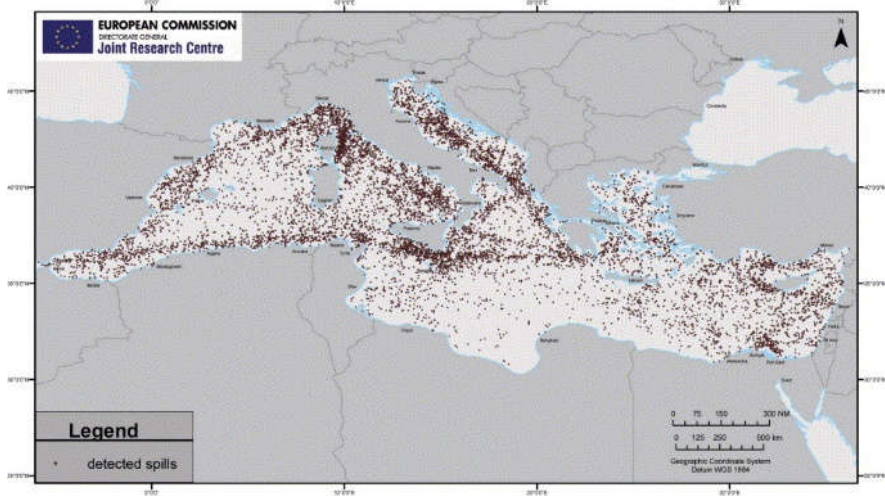
Figure 2. Possible oil spills in the Mediterranean Sea detected between 1999 and 2004—[10].